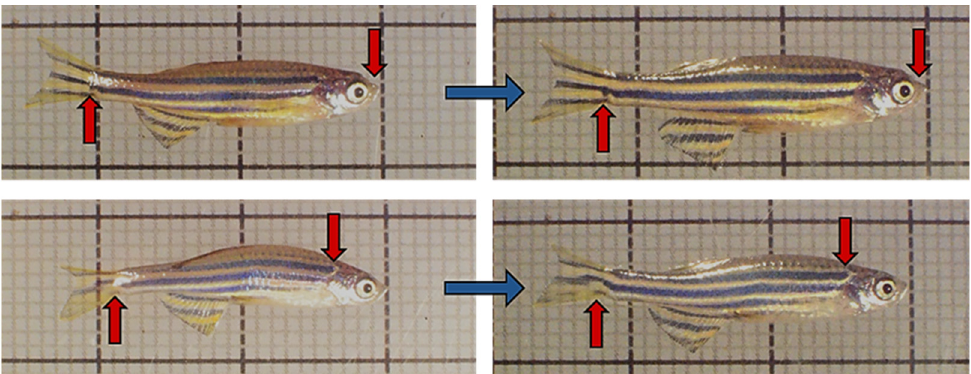
Figure 1. Example of the identification of two fishes through the observation of individual body and livery phenotypic traits (red arrows); photos on the same line (blue arrows) refer to the same fish photographed at an earlier and later time point (the pictures show 2 weeks of difference).